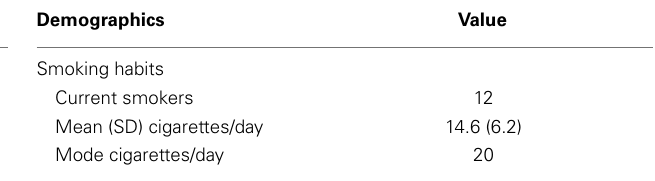
Table 1 | Summary of participant demographics ( N = 26)